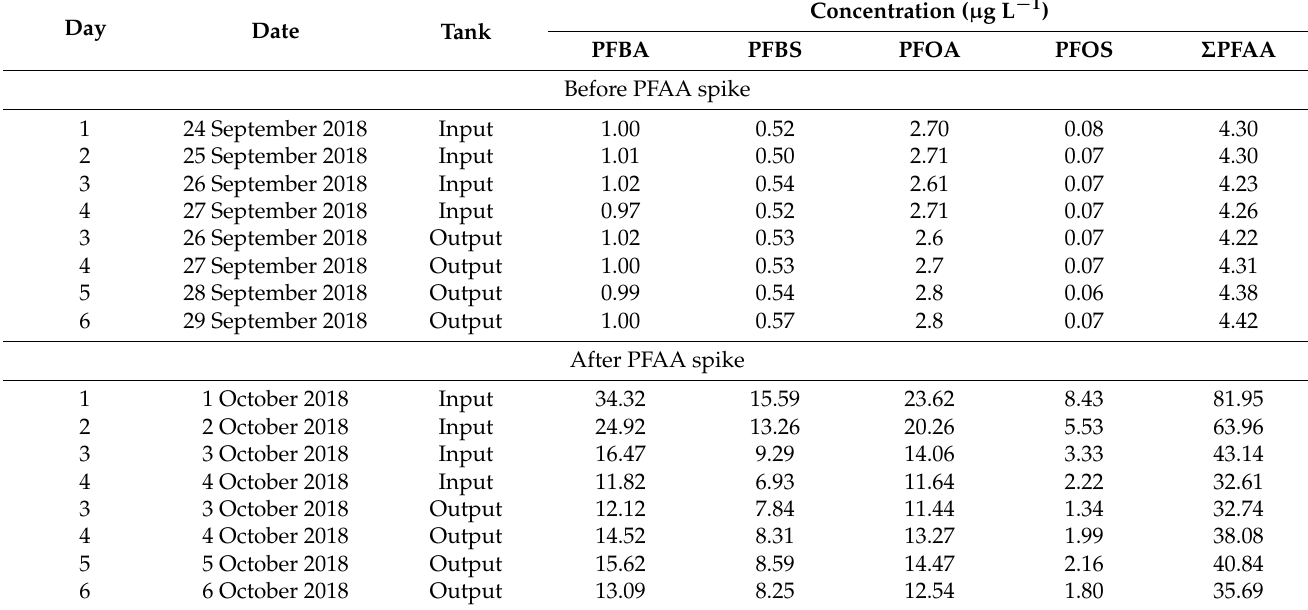
Table 2. PFAA Concentration in Water Expressed Both as a Single Congener (PFBA, PFOA, PFBS, PFOS) and the Sum of the Same ( Σ PFAA). It is Important to Recall That the Autosampler in the Outlet was Activated Two Days Before that one at the